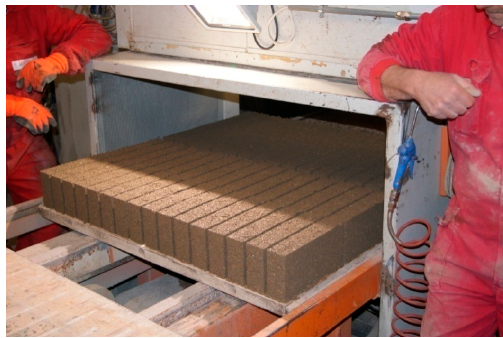
Figure 3. Fresh blocks outgoing from the mold box. Buildings 2016 , 6 , 40